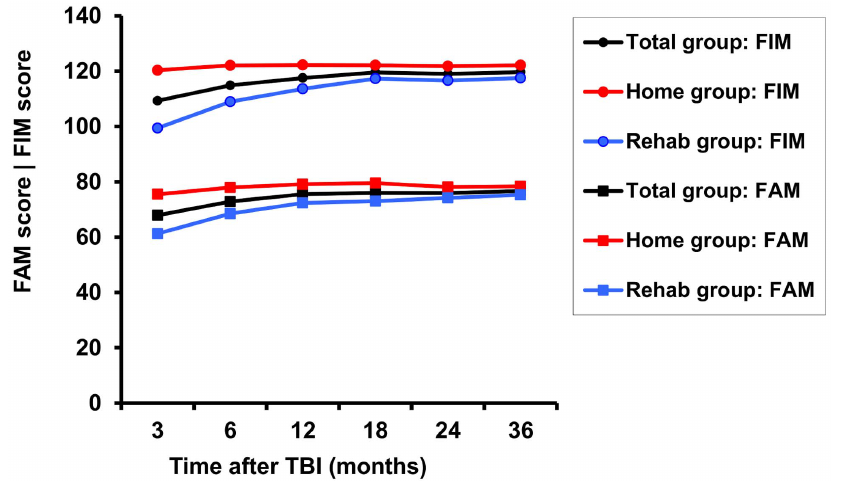
Figure 2. Estimated mean Functional Independence Measure (FIM) and Functional Assessment Measure (FAM) scores over time in the Rehab group (blue line; n=53), Home group (red line; n=45), and total group (black line; n=98).